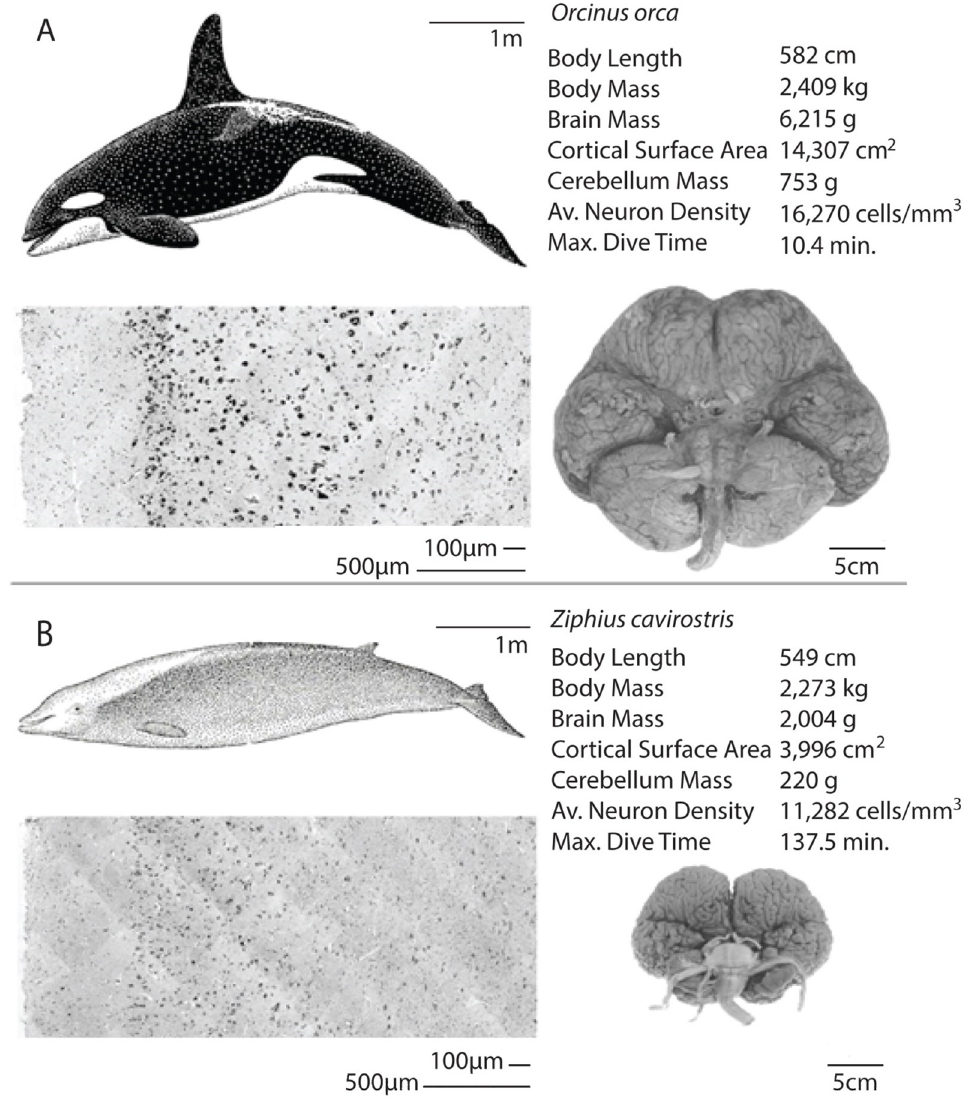
Fig 4. Comparison of a larger short diver and a larger long diver. An illustration of the differences in brain mass, cortical surface area, cerebellum mass, average neuron density, and maximum dive time between one female adult delphinid ( Oo ; A) and one female adult ziphiid ( Zc ; B) of similar body size. Zc , which can dive deeper than a mile and longer than an hour, has a smaller brain with fewer neurons than that of Oo , an animal of similar body size that performs shallower, shorter